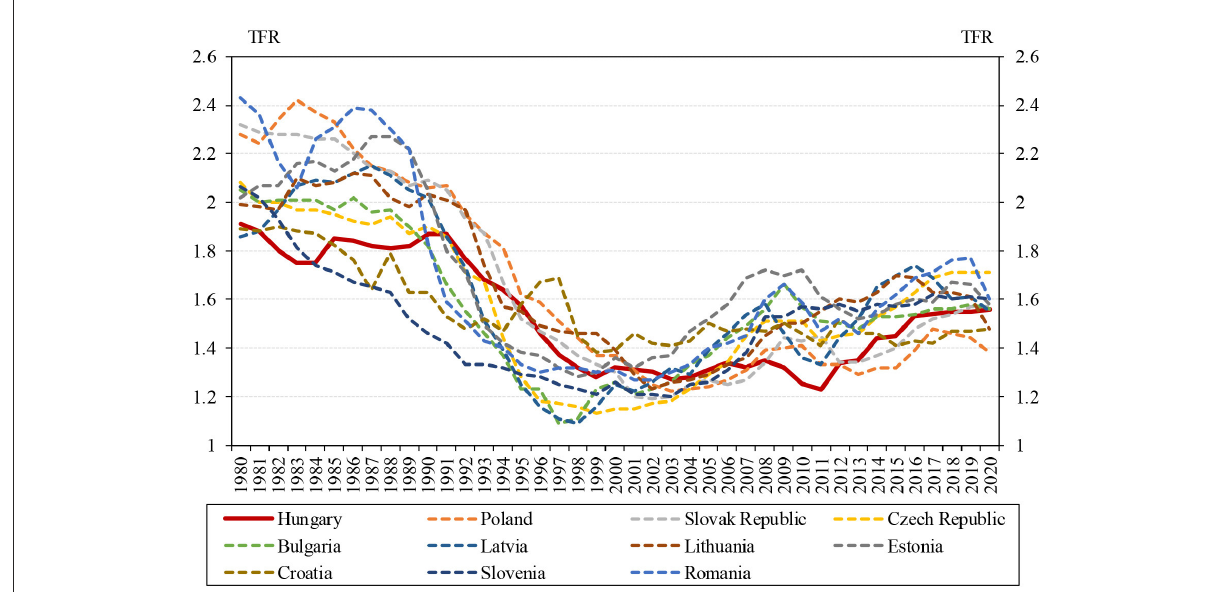
degree of political transition than other regime-changing countries. However, the degree of fertility transition experienced in these countries is roughly the same as in other regime-changing countries. It is true that Croatia did not witness the slight increase in TFR in recent years that most of the other countries did, but this also happened in Bulgaria and Estonia.